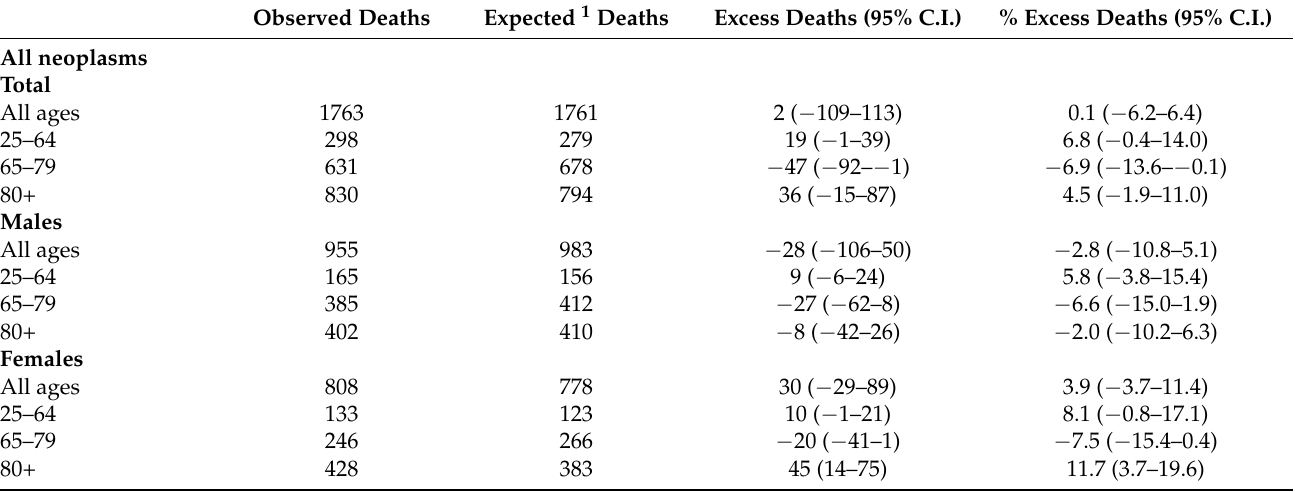
Table 3. Number of observed and expected deaths, along with the excess mortality estimates in 2021, for all neoplasms and circulatory system diseases, at all ages and three age groups, in the total, males and females population. Pavia province, Lombardy region, Italy.